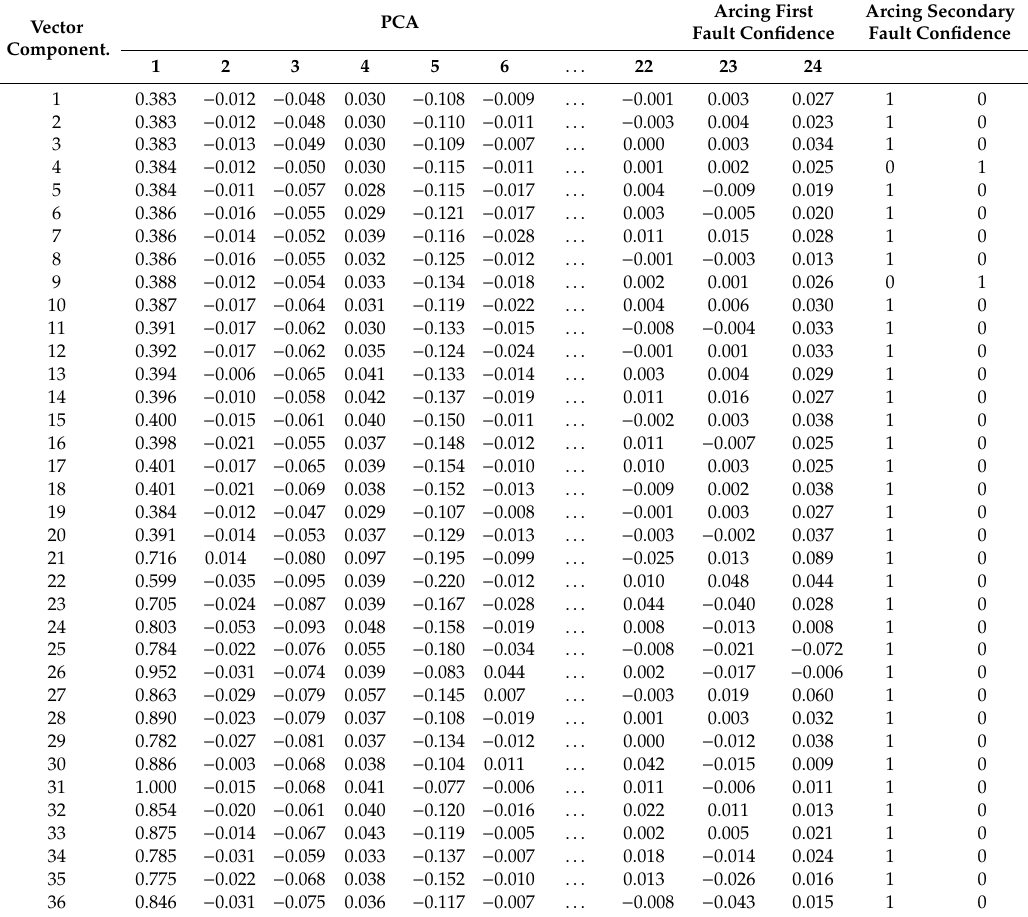
Table 2. Obtained results of classification with Support Vector Machine